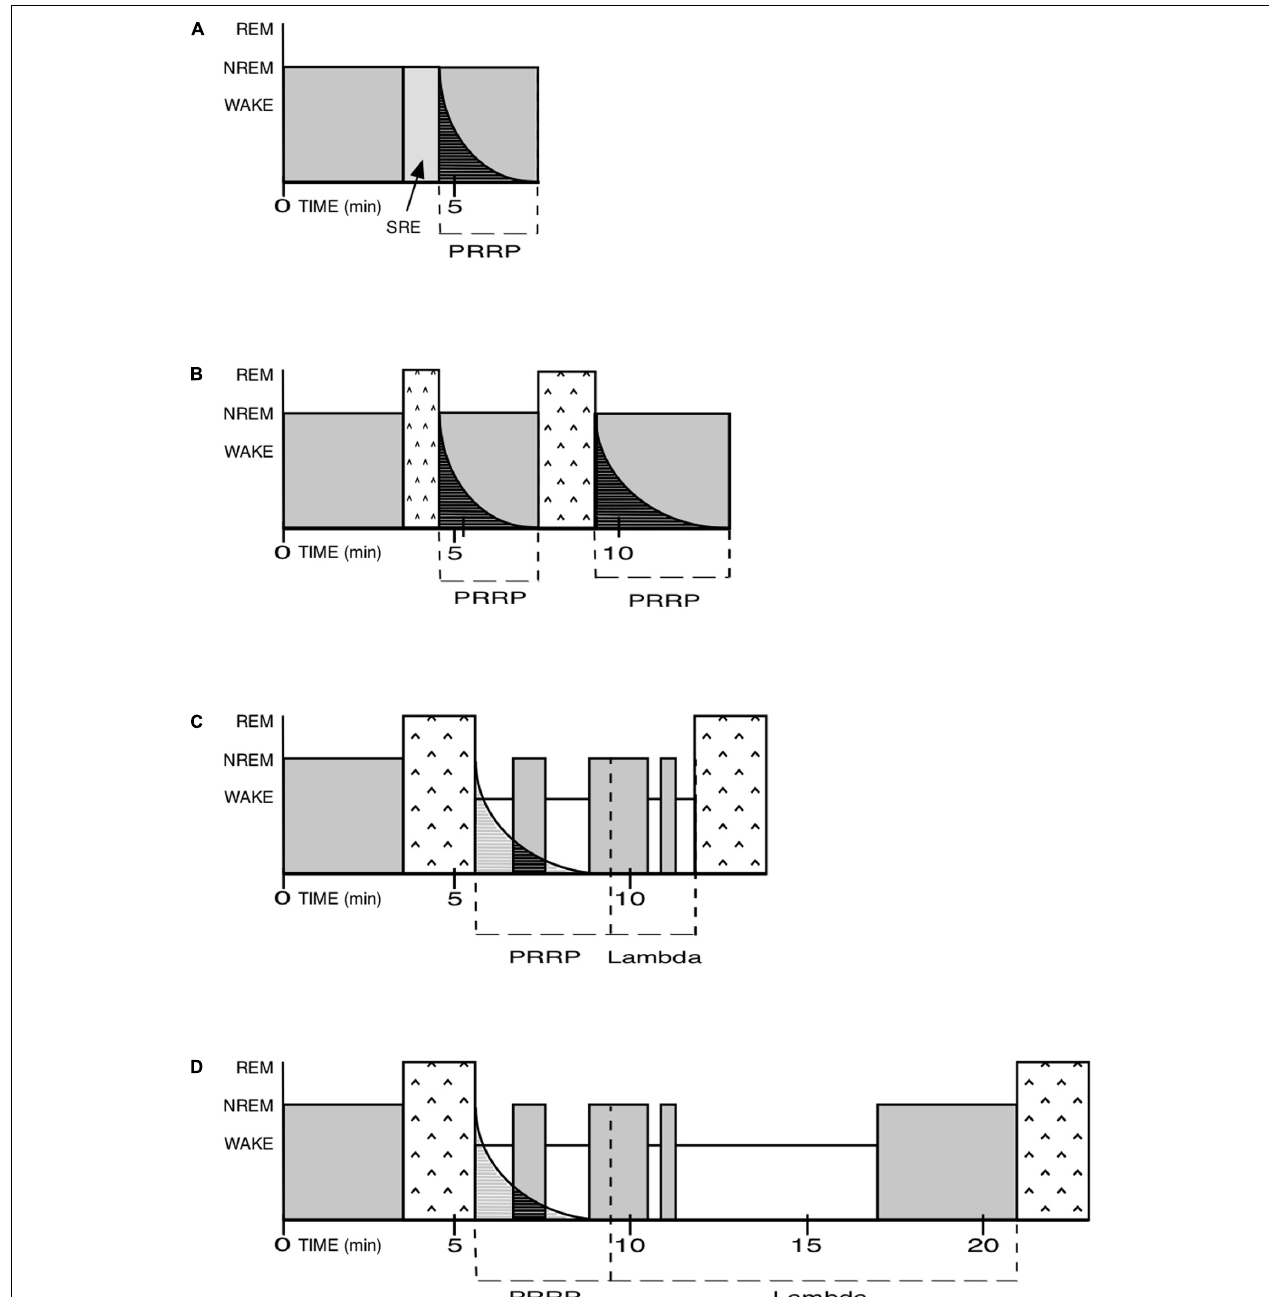
FIGURE 3 | NREM and REM pressure, PRRP and Lambda. PRRP for Post-REM refractory period. SRE for Skipped REM Episode. In order to simplify the examples below, the REM pressure is assumed to be constant here, whereas in reality it is determined by its long-term pressure, and may also be higher or lower. In real nights, it is the balance between both pressures that will determine the local patterns. Please note that the time scale used here is for mice and should be adapted for other species. (A) As in human nights, especially at their beginning, SRE: the NREM pressure is very high and completely blocks the attempt by the REM pressure to create a REM episode. (SRE are only evidenced by a lighter level of NREM sleep, see p.7). The PRRP then in turn also blocks attempts by the REM pressure to create a new REM sleep episode. (B) As in human nights, especially at their beginning: the NREM pressure is high but loses some ground. It prevents the REM pressure to create a “full-fledged” first REM episode and forces it to shut down after a while. The PRRP following it blocks any attempt by the REM pressure to create a new REM episode. When the PRRP is complete, a new, usually longer, episode of REM sleep is created, followed by a proportionally longer PRRP than the first one. The Lambda duration is zero in in the first case and indeterminate in the second. (C) Human (mostly at the end of nights) or rodent: the NREM pressure is lower here and allows a full-fledged REM episode to appear. Full-fledged REM sleep episodes limit their own duration.The PRRP then prevents REM sleep pressure to launch a new REM episode too rapidly after the one just ended. The Lambda duration is relatively short in the example. (D) Human (for example in cases of insomnia) or rodent: same as above but with a longer Lambda.